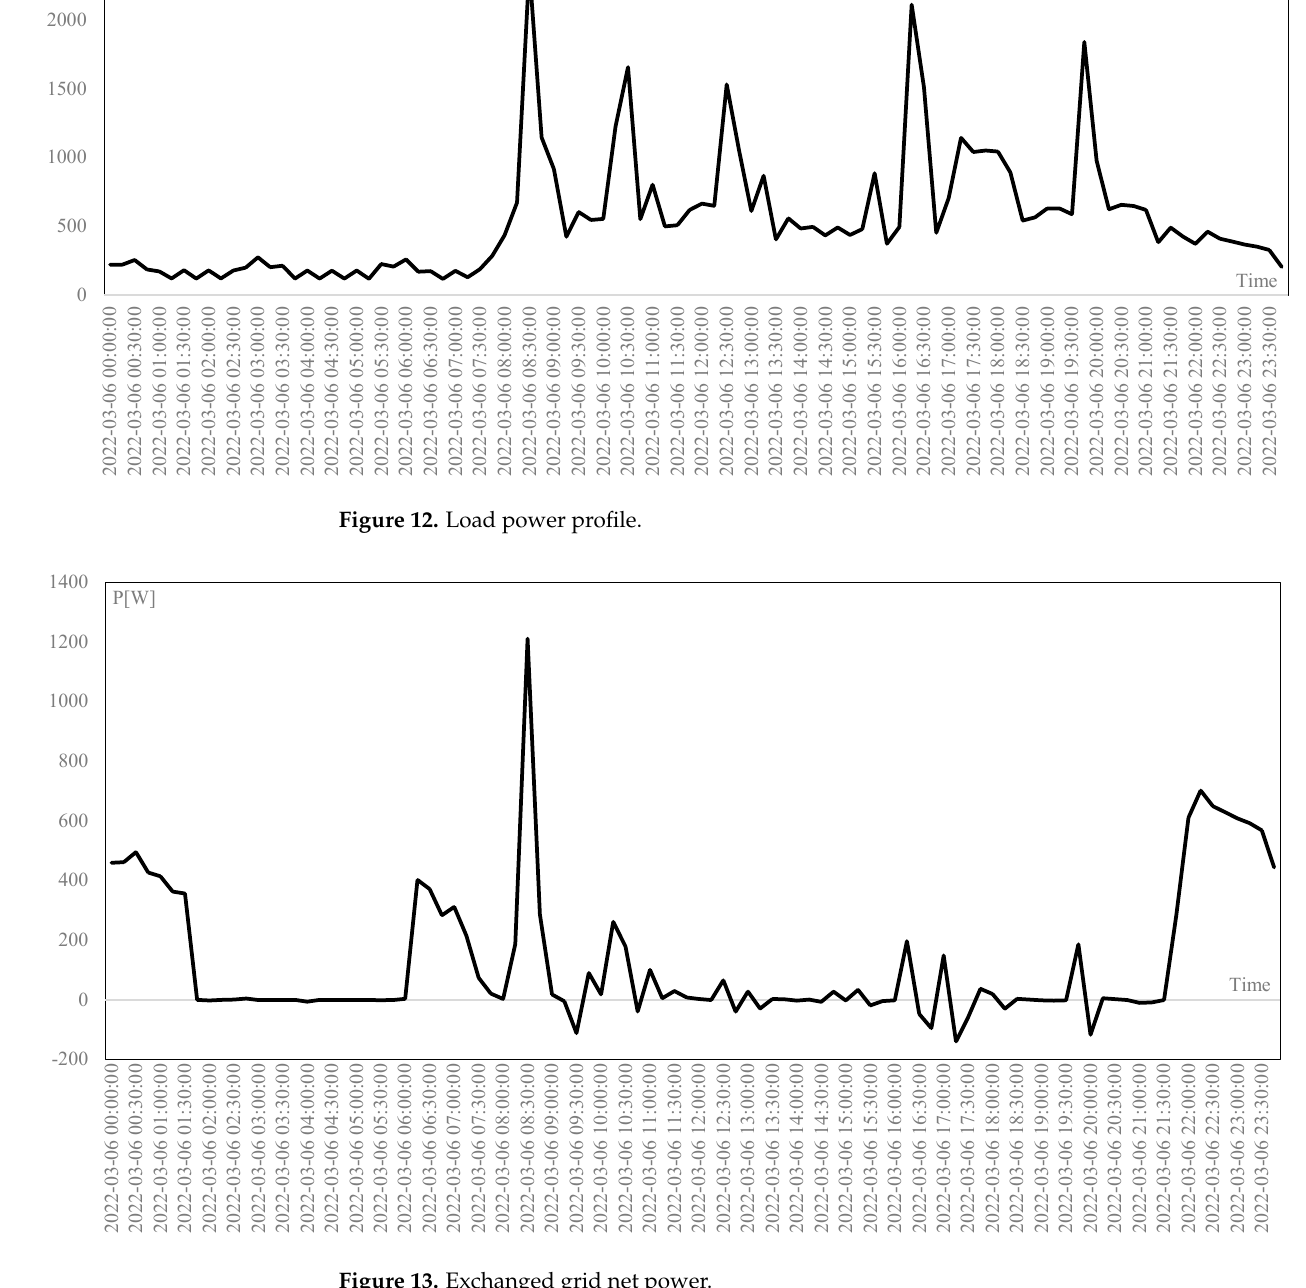
Figure 14. ESS exchanged power profile.